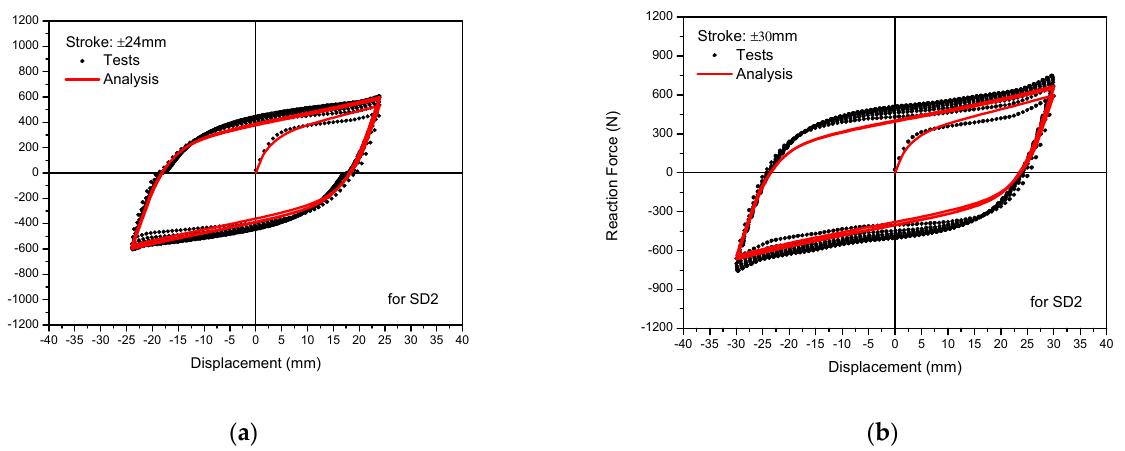
Figure 19. Comparison results of hysteretic behavior between tests and analyses for steel damper, SD2: ( a ) for ±24 mm stroke; ( b ) for ±30 mm stroke.